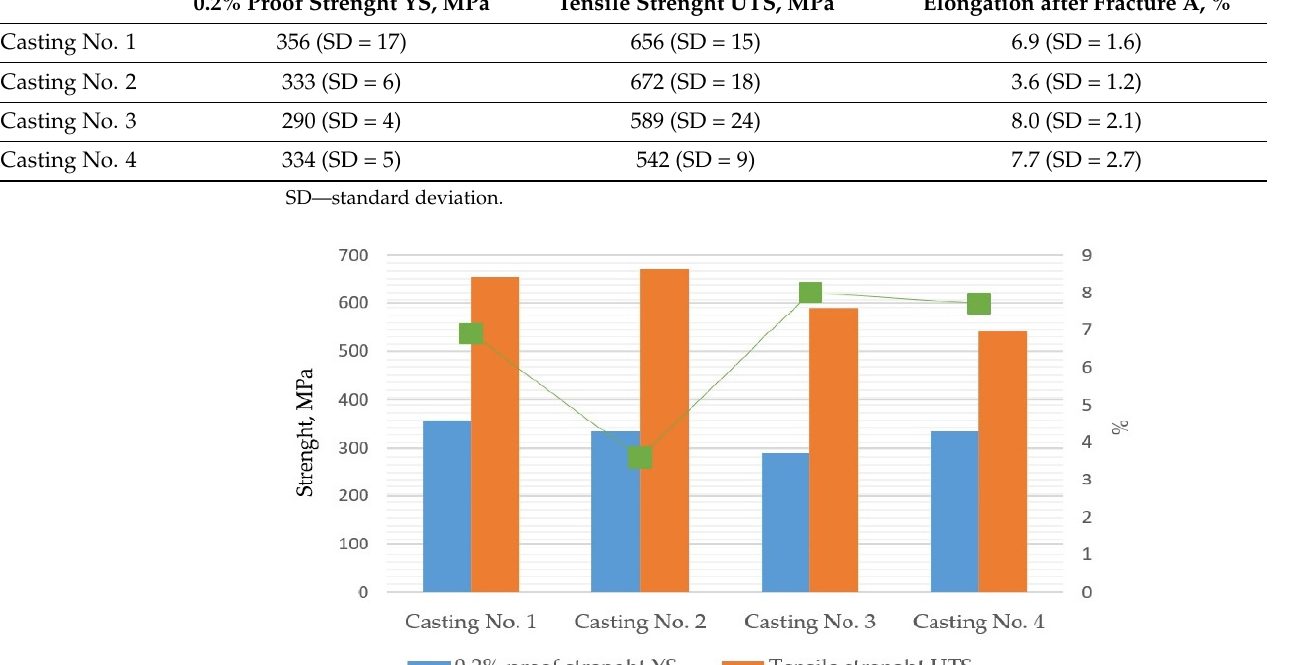
Table 3. Tensile test results of the specimens from the examined castings (average of 3 results).